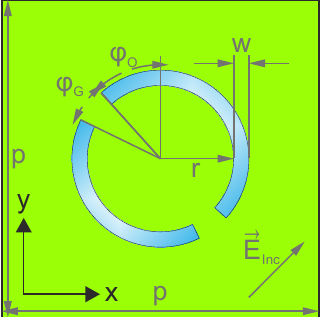
Figure 2. aDSRR unit cell with dimensioning.